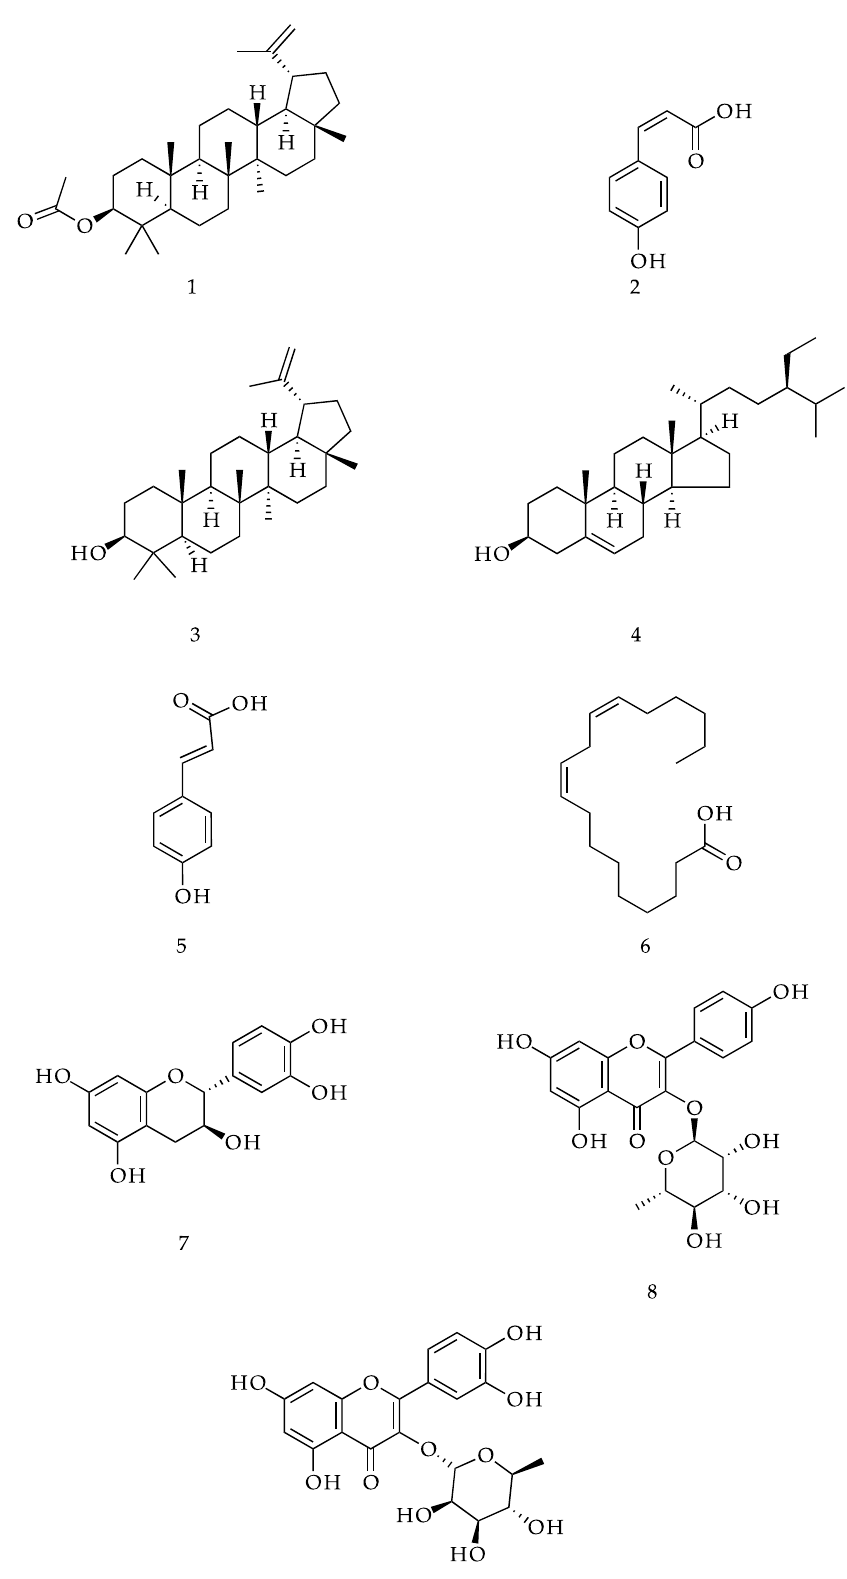
Figure 1. Structure of compounds ( 1 – 9 ) isolated from Muehlenbeckia tamnifolia .